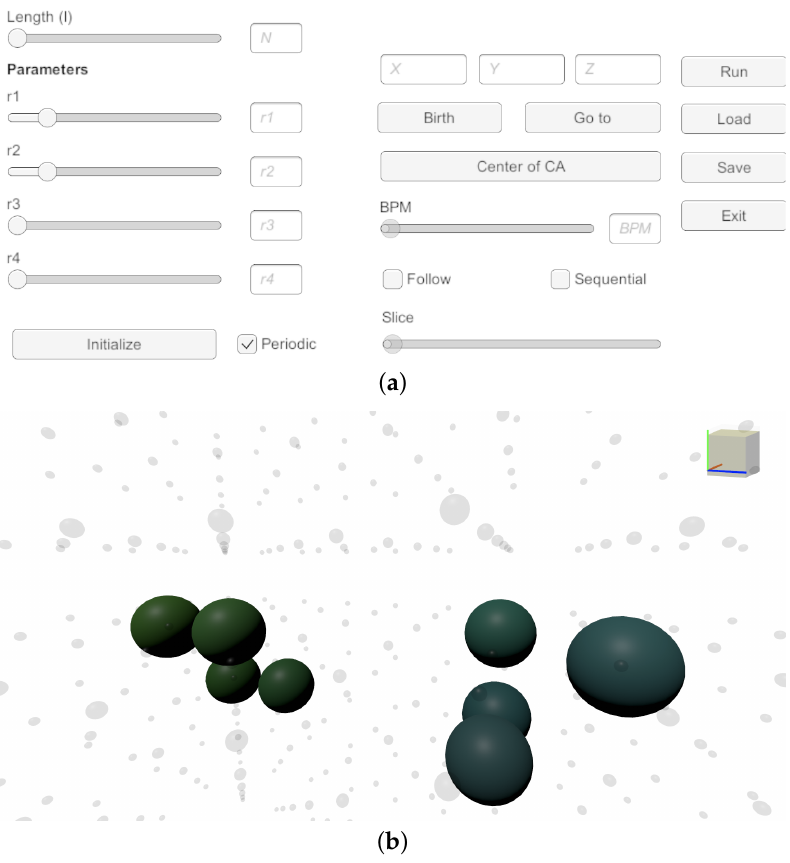
Figure 3. Menu and rendition mode screen shots. ( a ) Menu Mode. ( b ) Rendition